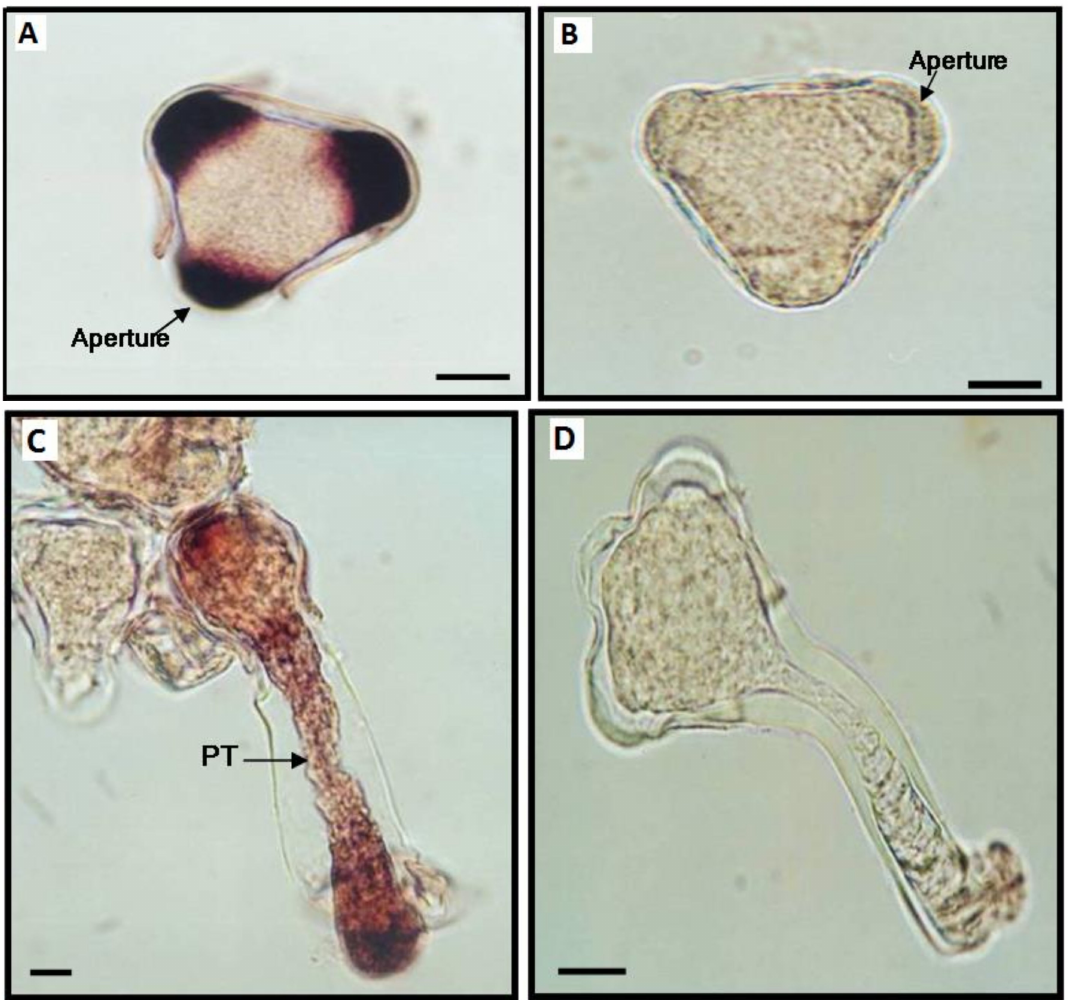
Figure 7. Prunus necrotic ringspot virus (PNRSV) RNA localization by whole mount in situ hybridization. ( A ) Viral RNA (purple color) is specifically localized in fully mature pollen grains at their apertures. ( B ) Uninfected pollen grain (negative control of the in situ hybridization) showing no purple color. ( C ) Infected, germinated pollen grain showing the PNRSV RNA (purple color) present not only inside the pollen grain but also inside the pollen tube (PT), especially on the tip. ( D ) Healthy, germinated pollen grain showing no positive signal after carrying out the whole mount in situ hybridization. Bar = 10 µ m. This figure is adapted with permission from